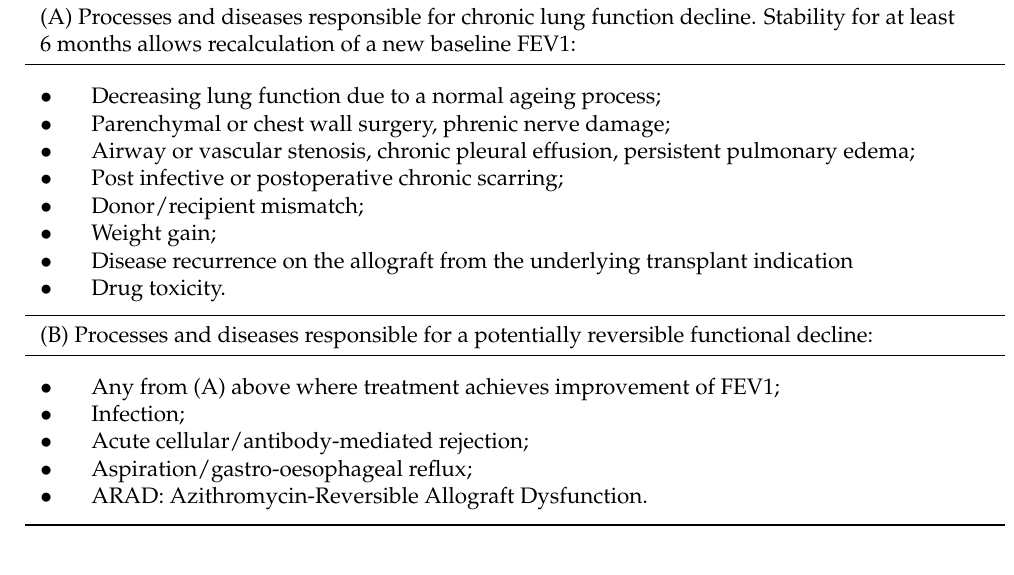
Table 1. What is not included in the definition of CLAD (adapted from [5]).